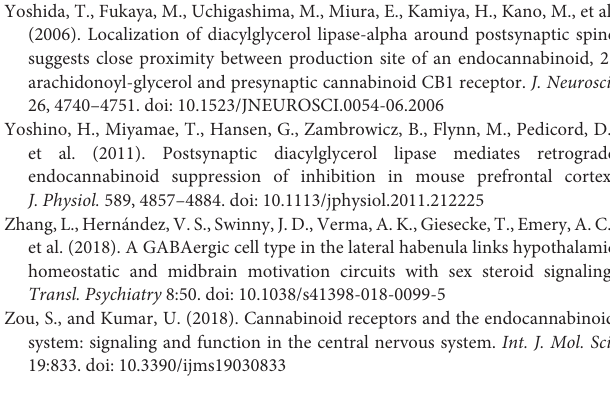
Conflict of Interest : The authors declare that the research was conducted in the absence of any commercial or financial relationships that could be construed as a potential conflict of